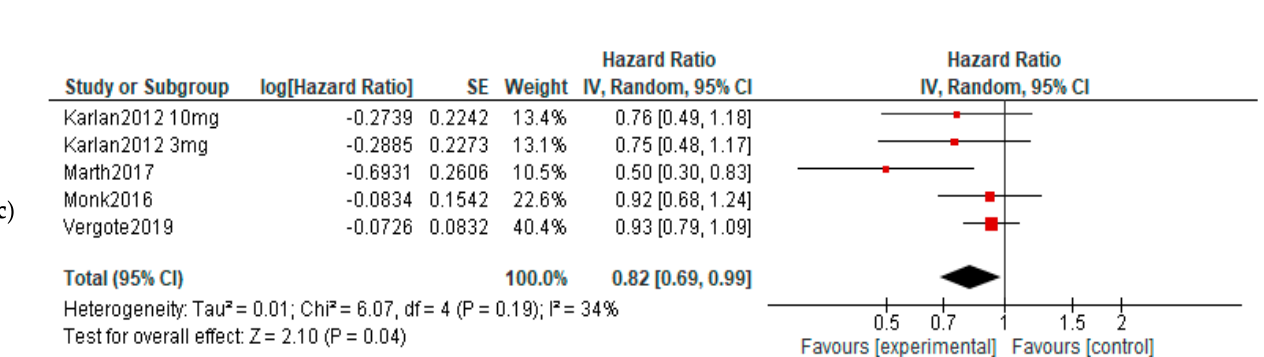
Figure 5. Action-mechanisms subgroup analysis of progression: ( a ) VEGF inhibitors, ( b ) VEGF-R inhibitors and ( c ) angiopoietin inhibitors. The black diamonds are visual representations of pooled effect and its confidence intervals and are non-significant if they overlap 1. Red squares represent each study effect size and study weight (size of square). The lines represent each study confidence interval. PLm—placebo maintenance; BEVm—bevacizumab maintenance [26–30,32,34–48,50,52].